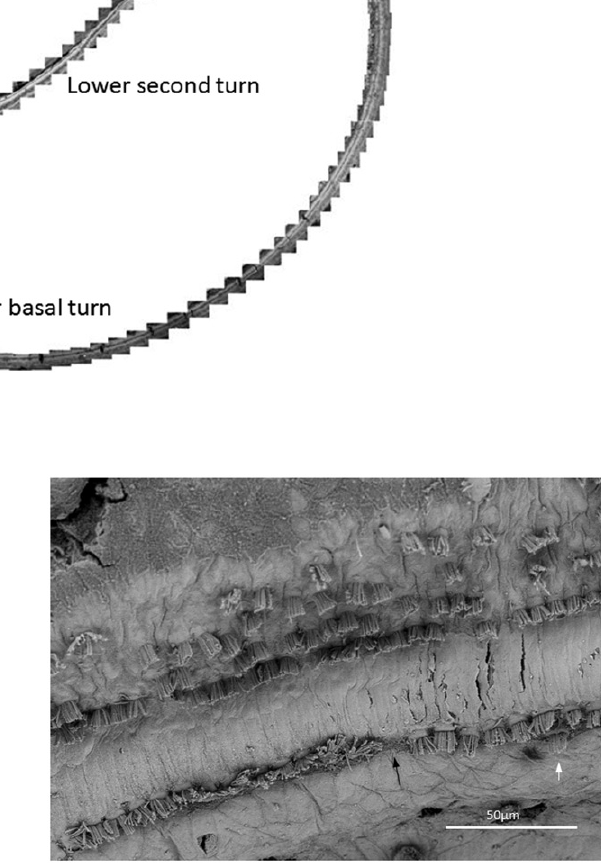
Figure 4. FESEM of the framed area shown in Figure 3(b). The image approxi- mately represents the 300-Hz region. Four to five rows of OHCs are present, of which the second to fifth rows are incomplete. The left arrow shows one miss- ing IHC. The right arrow shows a sIHC located against the modiolar